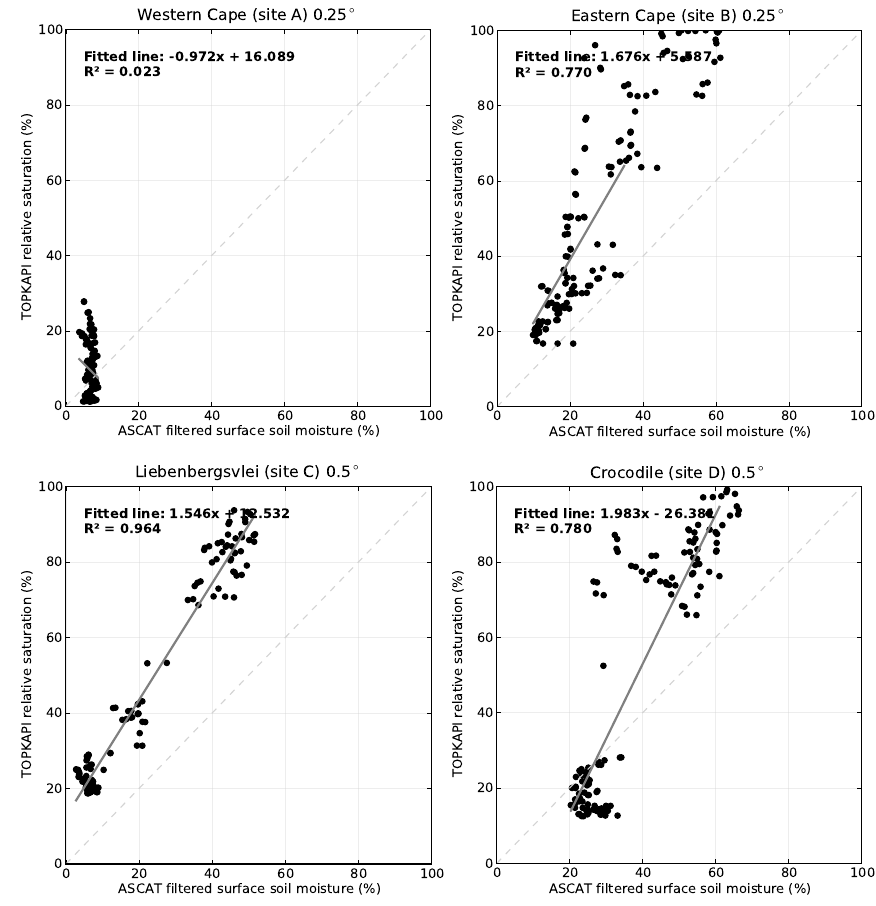
ASCAT filtered surface soil moisture